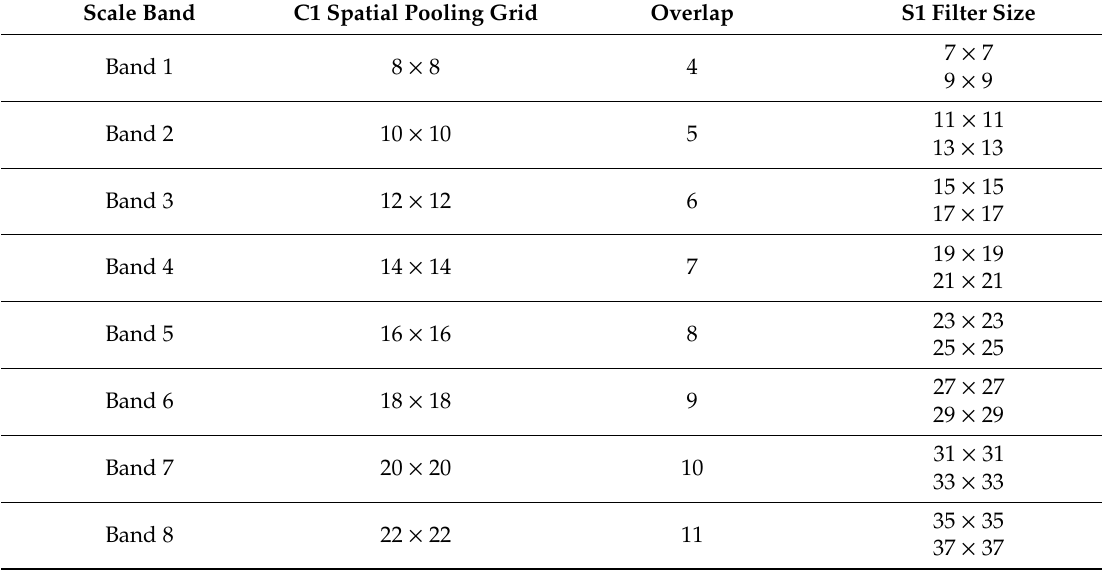
Table 2. Parameters of Gabor filters adopted in the S1